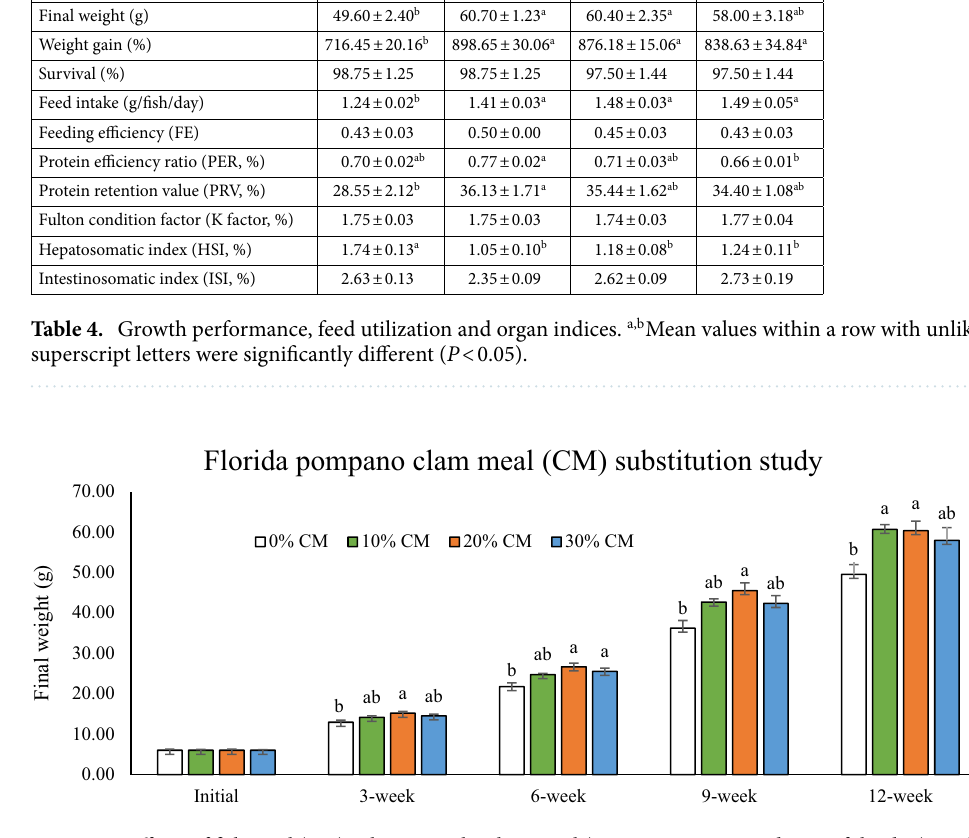
Figure 1. Effects of fish meal (FM) substitution by clam meal (CM, at 10%, 20% and 30% of the diet) on the final weight at different weighing periods of Florida pompano fed the experimental diets for 12 weeks. Values are means with standard errors represented by vertical bars (n = 4). Mean values with different letters are significantly different (P <